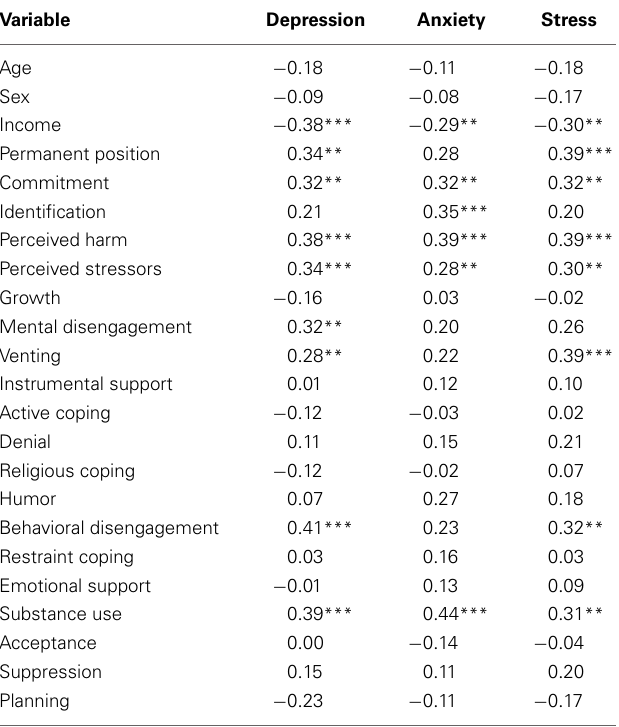
Table 8 | standard multiple regression predicting perceived stressors in the